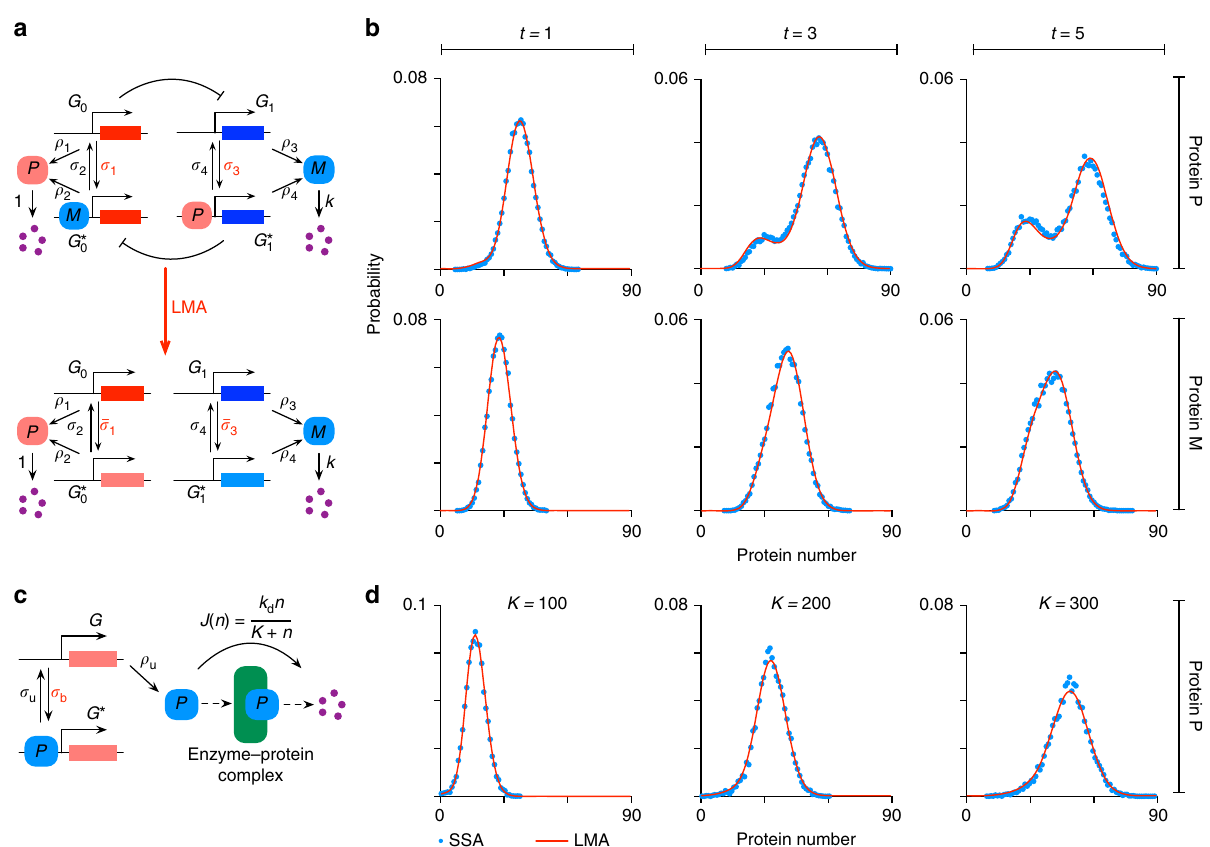
Fig. 5 LMA for the toggle switch and for a feedback loop with nonlinear protein degradation. a (upper panel) Illustrates a toggle switch (with two active and two inactive promoters), whereby two proteins P and M are expressed and mutually repress each other. (lower panel) illustrates how the toggle switch system is decoupled by the LMA into two independent linear networks. b Shows the LMA predictions for time-evolution of the marginal distributions of the two proteins, P and M , in the toggle switch for three different time points. The parameters are: ρ 1 = 60, ρ 2 = 25, ρ 3 = 45, ρ 4 = 30, σ 1 = σ 3 = 0.004, σ 2 = σ 4 = 0.25 and k = 1. c Shows the feedback loop with nonlinear protein degradation via an effective Michaelis – Menten reaction. d Shows the LMA predictions for steady-state protein distributions of the system shown in c for three different values of the Michaelin – Menten constant K . The other parameters are: ρ = 3, ρ = 0, σ = 4 × 10 − 4 , σ = 0.25 and k = u b b u d